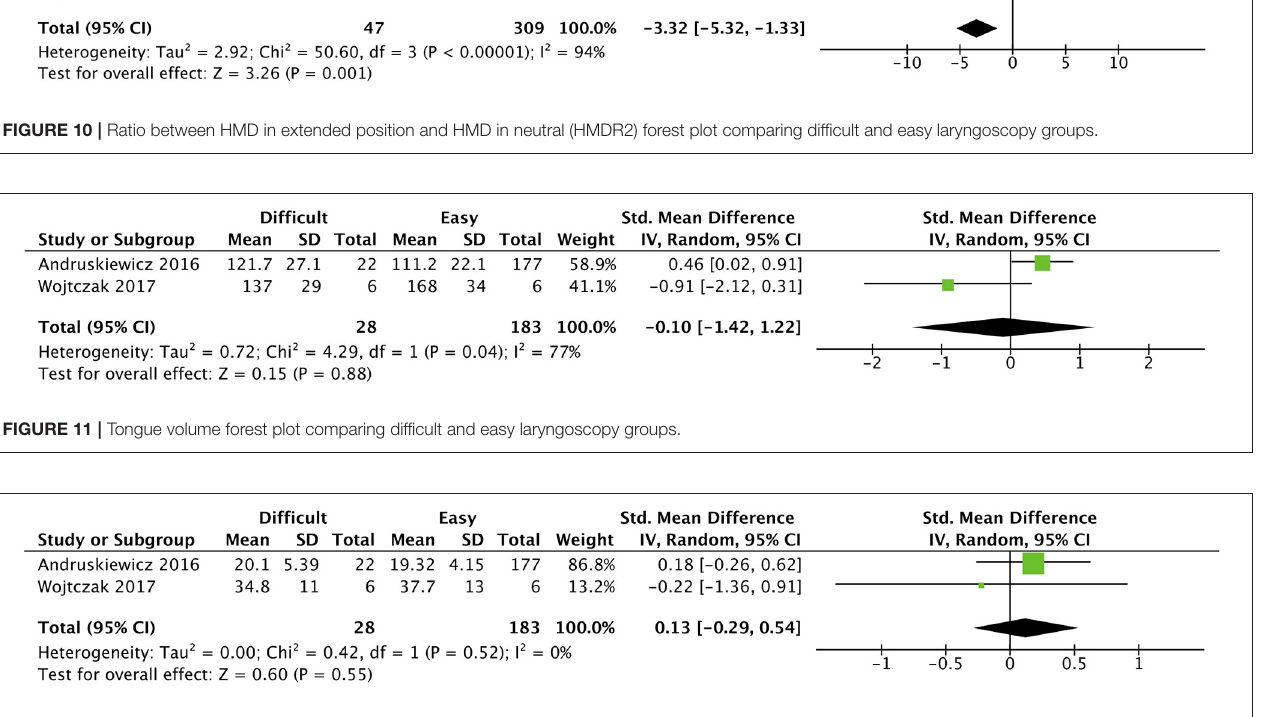
FIGURE 12 | Floor of mouth muscle volume forest plot comparing difficult and easy laryngoscopy groups.